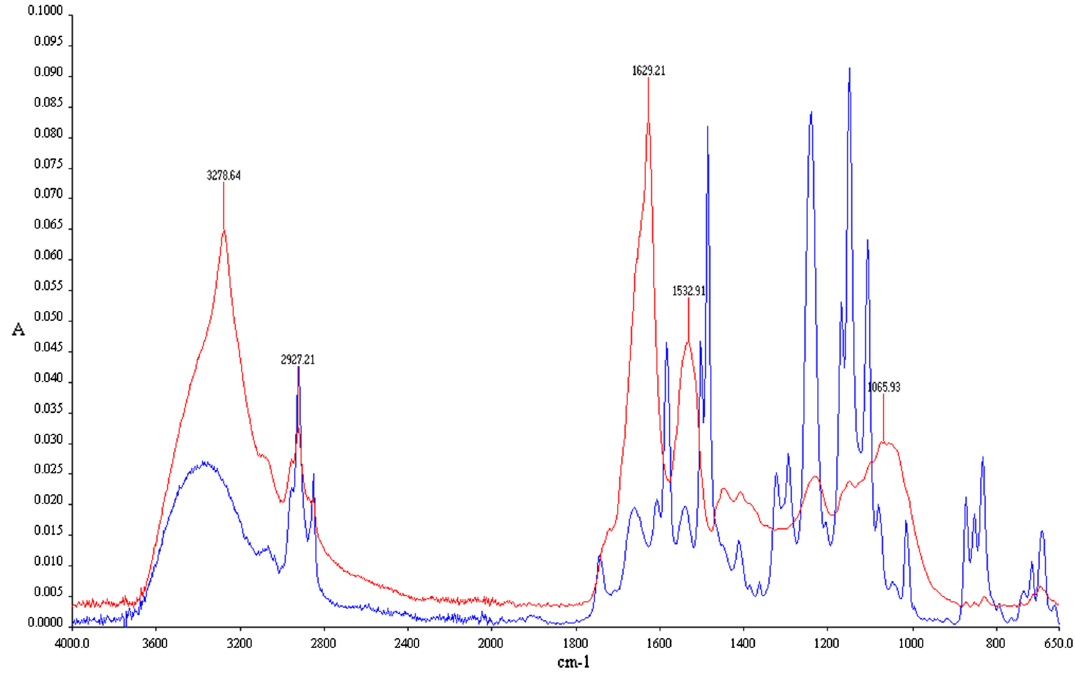
Fig. 11 FTIR spectra of the virgin (blue) and fouled (red) Saehan membrane